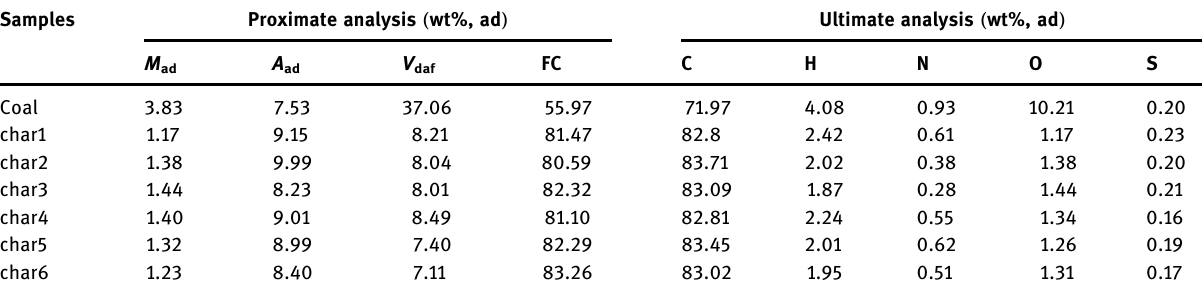
Table 1: Proximate analysis and ultimate analysis of coal and chars Samples Proximate analysis ( wt%, ad )